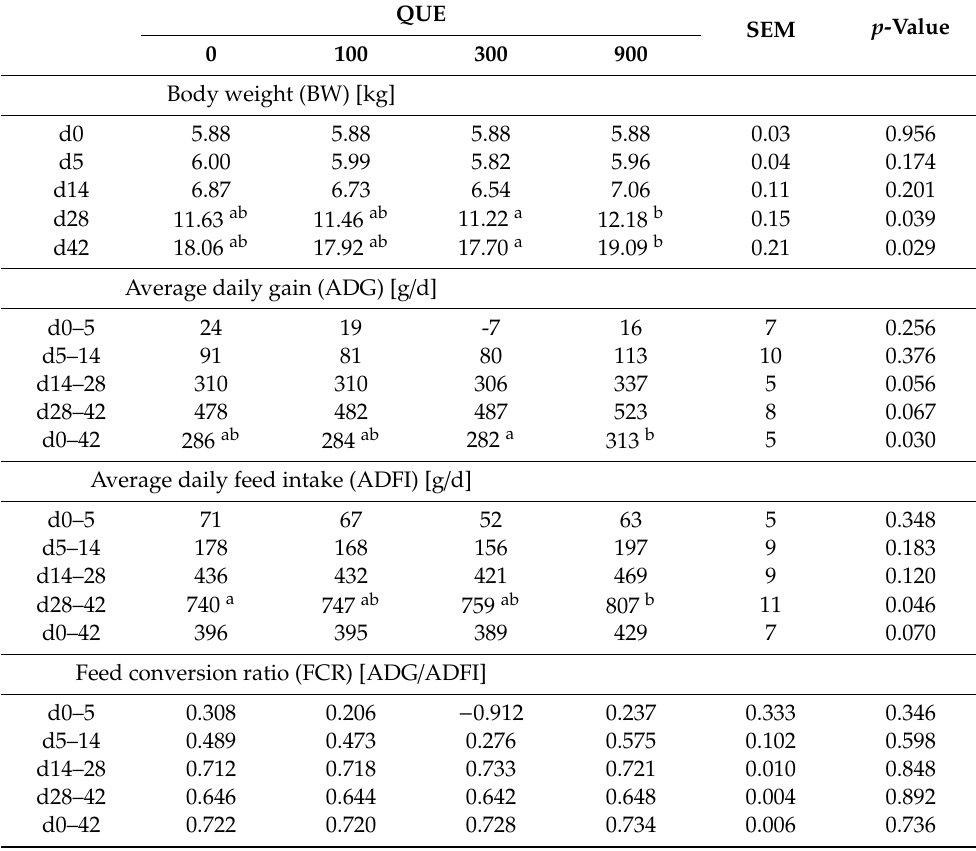
Table 2. The e ff ect of quercetin at doses of 0, 100, 300, or 900 mg / kg diet (QUE) fed during the first 14 days post-weaning on animal performance of piglets from d0 to d42 post-weaning ( n = 8). QUE SEM p